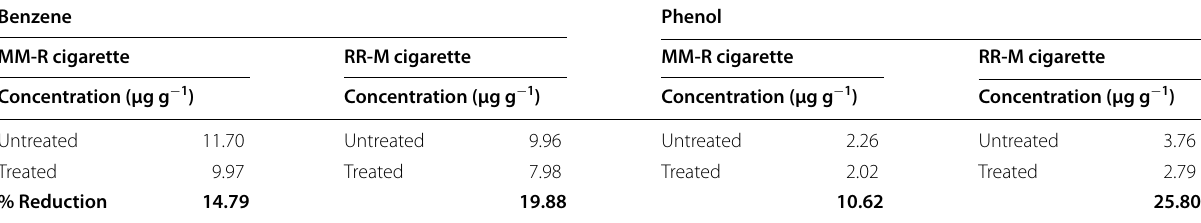
Bold values defined % Reduction of model tobacco chemical MM-R standard cigarette, RR-M local